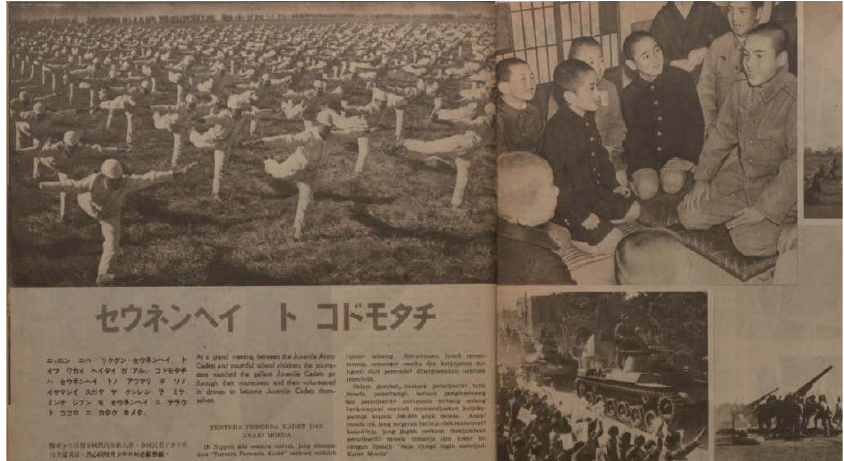
‘Sh nen-Hei to Kodomotachi’ [Youth Soldiers and Children], Taiyo¯ [The Sun], 1944, vol. 3, ō no. 1: 10–